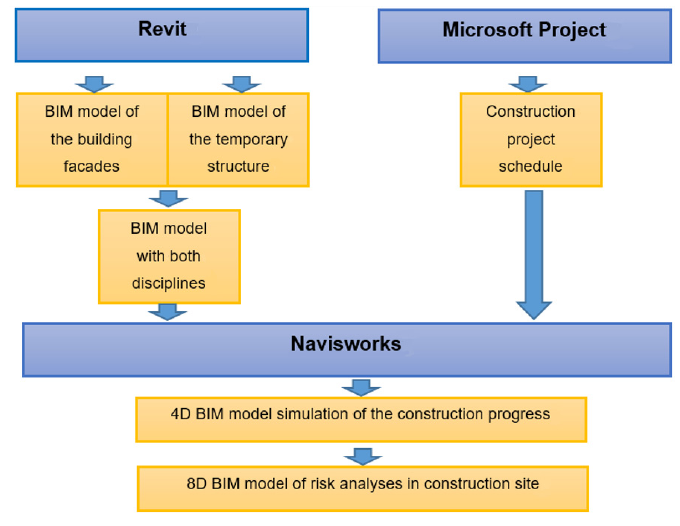
Figure 1. Scheme of the software used.